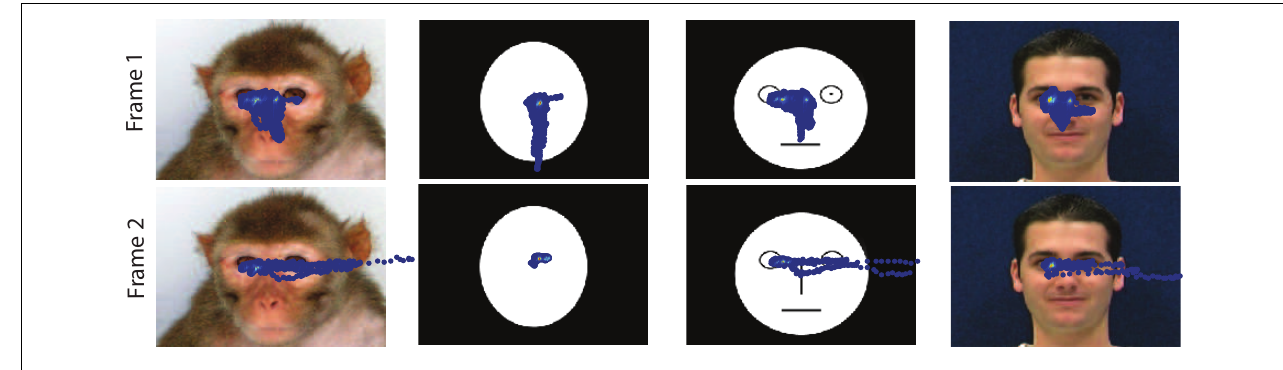
stimulus image was indicated by the heat-map color distribution. For both frame 1 (direct gaze) and frame 2 (averted gaze), the subject spent longest looking at the eyes of monkey-face, cartoon-face, and human-face